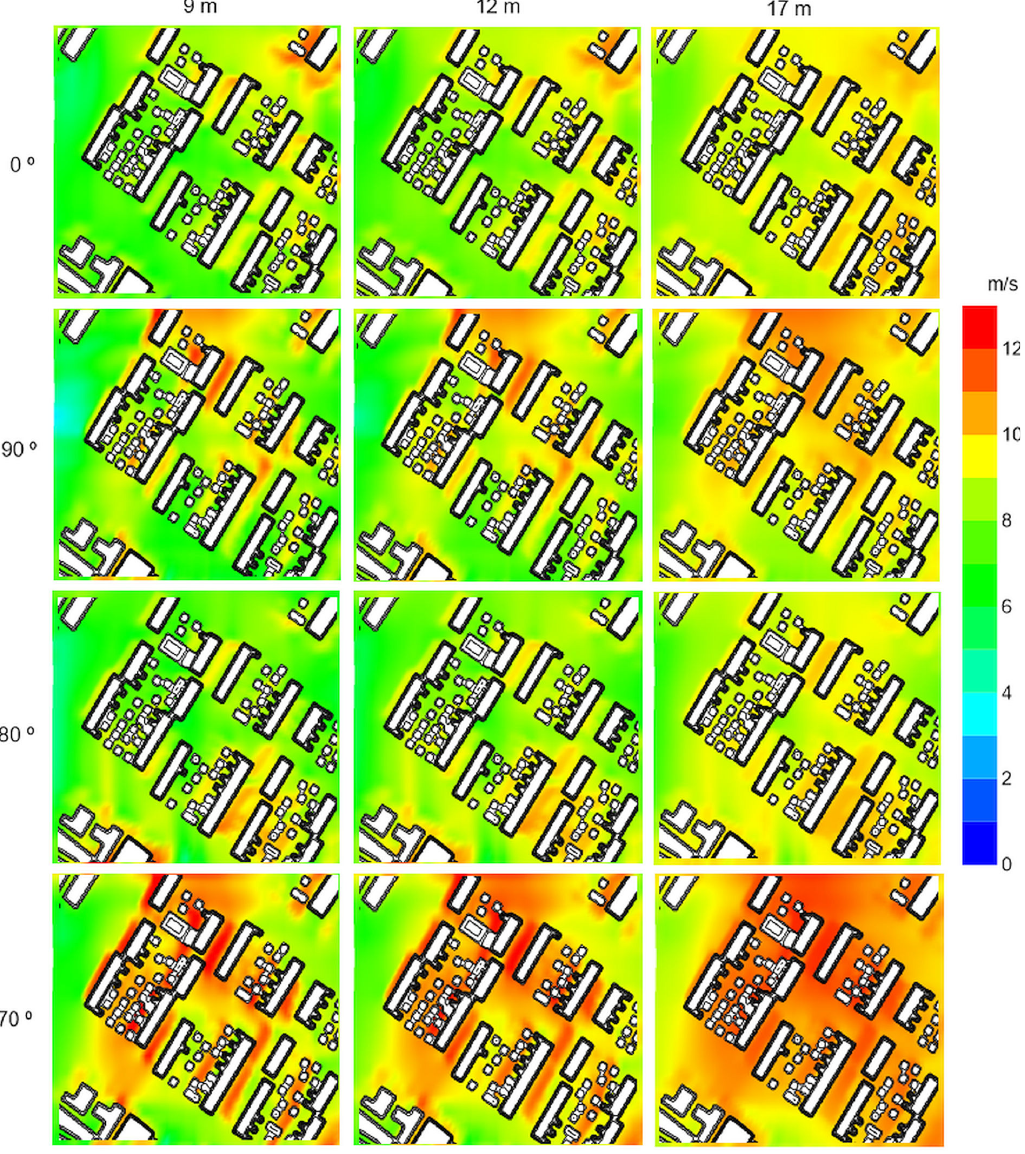
Figure 24. Mean wind speed estimates obtained by the WindSim model for three heights (9 m, 12 m, and 17 m) and four wind sectors rose (0 ◦ , 90 ◦ , 180 ◦ , and 270 ◦